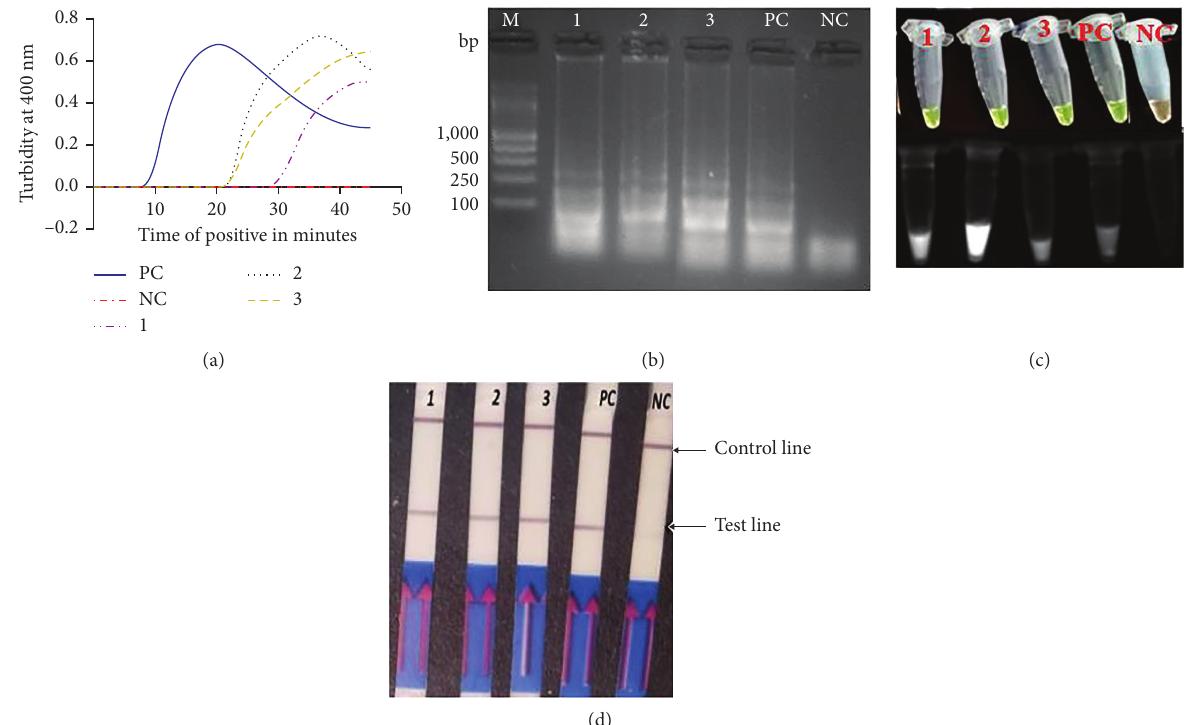
Figure 2: Detection of the LAMP products; the reaction was conducted at 63 ° C for 40 minutes. (a) Determination of the LAMP turbidity by a real-time turbidimeter. (b) 3% agarose gel electrophoresis of nested PCR products. (c) Visual detection using SYBR Green 1 dye under visible light and UV light. (d) LAMP-LFD detection: CL and TL indicate control line and test line, respectively. Lines 1–3 represent positive samples; PC is positive control and NC is negative control. Lane M: 1 kb DNA molecular